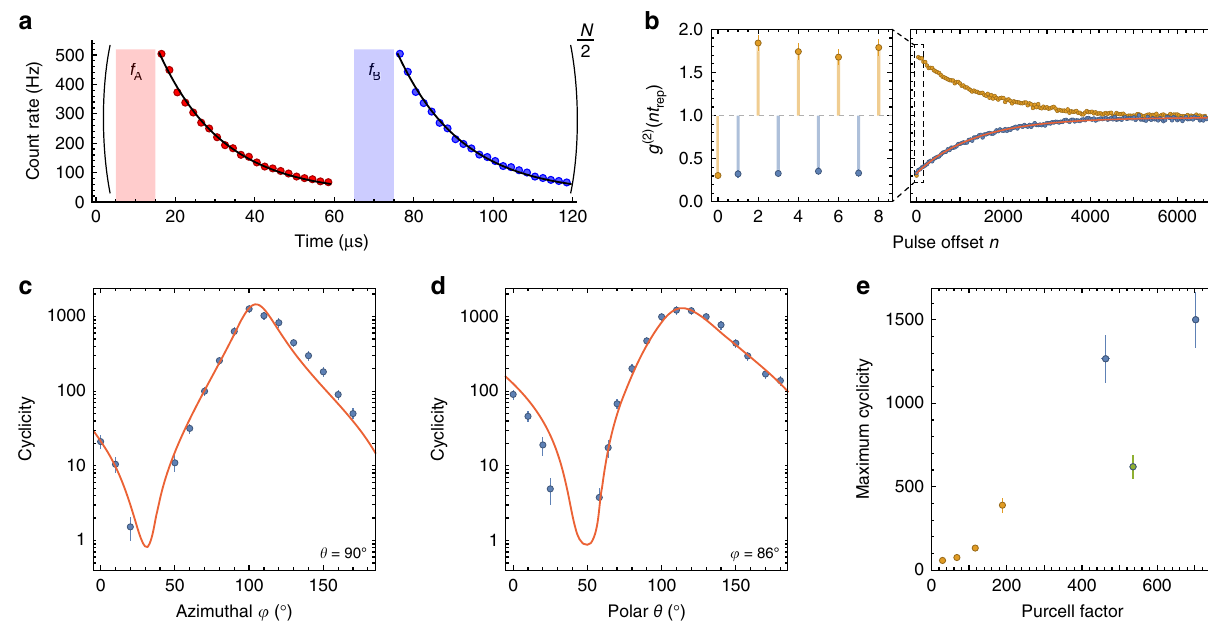
Fig. 2 Measuring the cyclicity of the optical transitions. a The measurement sequence consists of alternating pulses on the A and B transitions (10 μ s) followed by a fl uorescence collection window (45 μ s), repeating every t rep = 60 μ s. The fl uorescence lifetime is 16.2 ± 0.2 μ s, shortened from its free-space value of 11.4 ms by P = 703 ± 6 in this device. b The intensity autocorrelation g (2) is computed from the integrated fl uorescence after each pulse. Odd values of n (blue points) probe the correlation between pulses driving different transitions and are anti-bunched as a result of the spin staying in the same state over many excitation cycles. g (2) decays as e (cid:3) n = n 0 because of optical pumping, giving the cyclicity C ≈ n 0 /2. In this measurement, C = 660 ± 66. g (2) (0) = 0.3 is consistent with the signal-to-background ratio of 10. c , d The cyclicity varies dramatically with the angle of the external magnetic fi eld, but is described by a model (red line) based on the independently measured g tensors (see text). e The cyclicity decreases rapidly with the Purcell factor, demonstrated here by measurements on several ions (shown in different colors) with the detuning varied to change P . In all plots, error bars denote estimated ±1 σ statistical